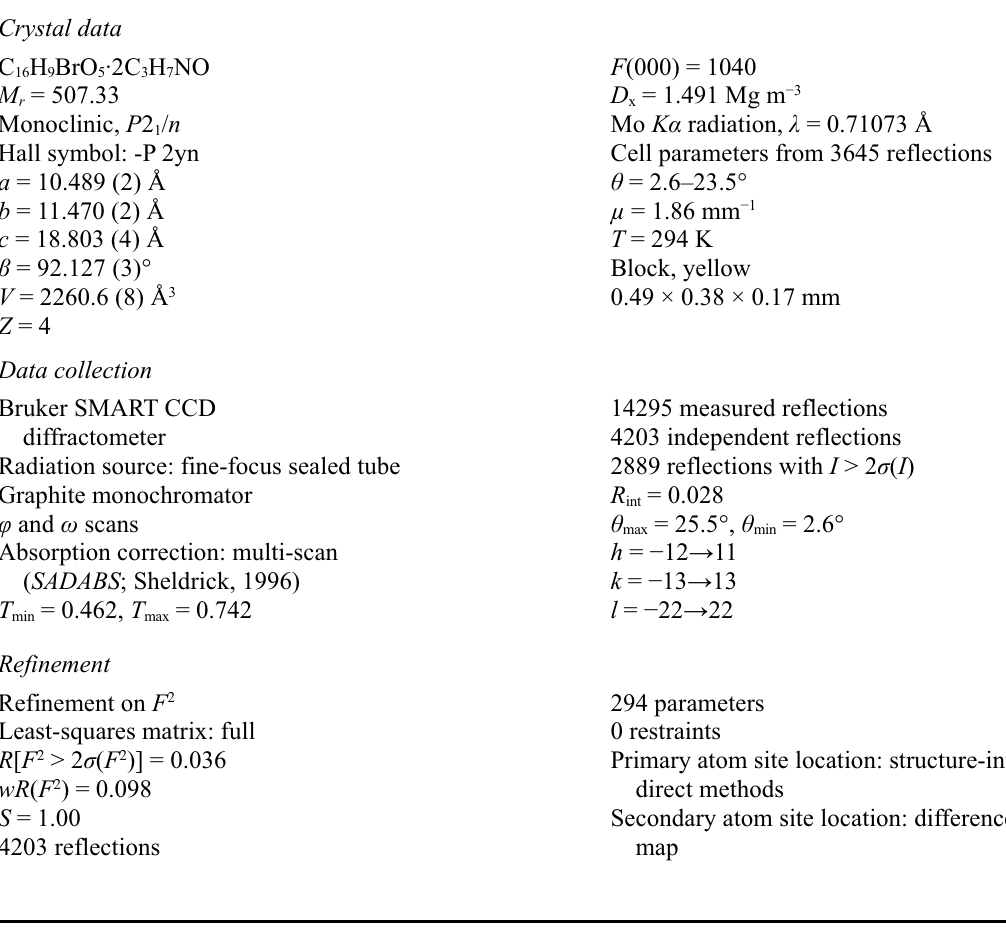
Figure 1 The molecular structure of (I), with the atom-labelling scheme. Displacement ellipsoids are drawn at the 30% probability level and H atoms are represented as small spheres of arbitrary radii. The hydrogen bonds are shown as dashed lines. 6-Bromo-3-hydroxy-4-oxo-2-phenyl-4 H -chromene-8-carboxylic acid dimethylformamide